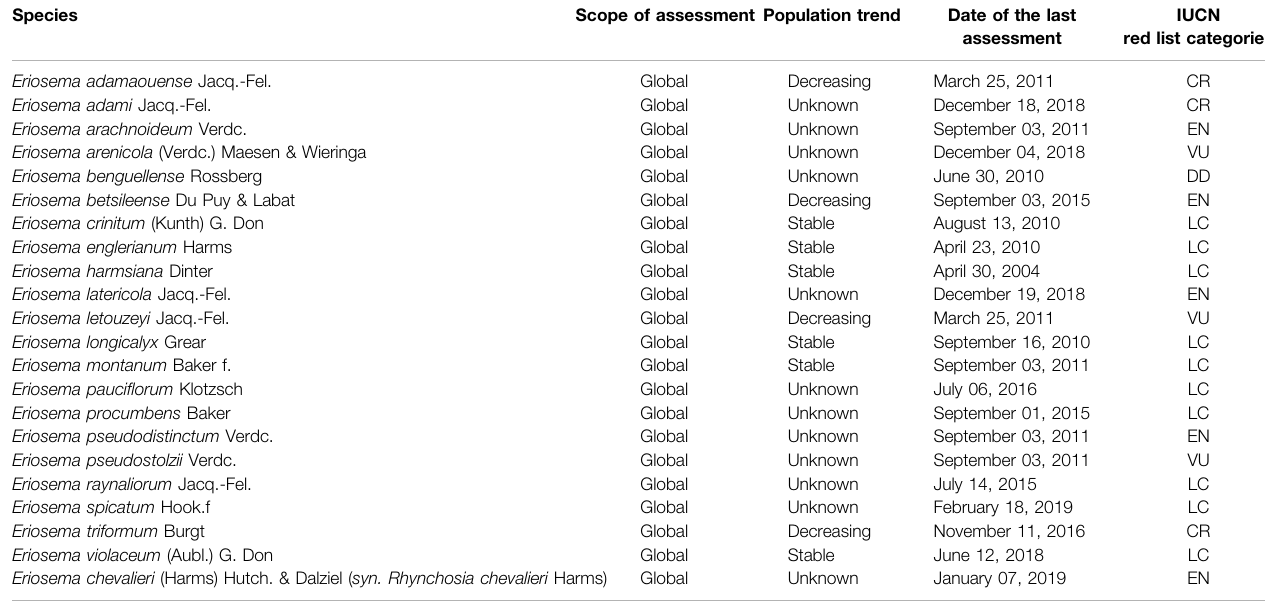
TABLE 2 | The International Union for Conservation of Nature (IUCN) Red List Categories of Eriosema species. Species Scope of assessment Population trend